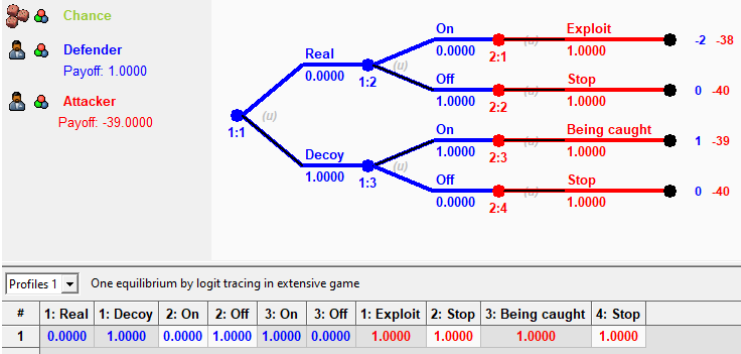
Figure 9. Results of the dominance for N 50 .